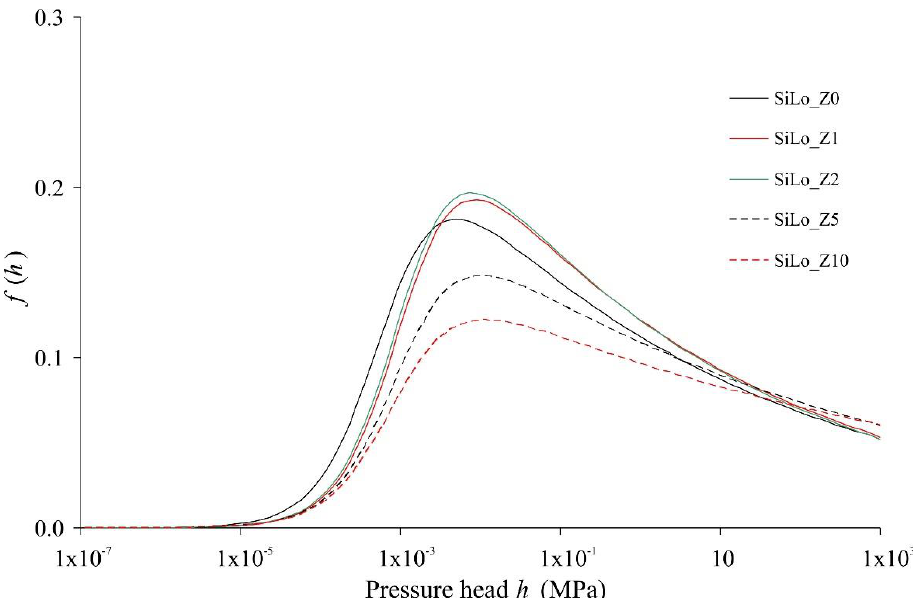
Figure 6. Pore size distribution (PSD) as a function of the pressure head h with reference to the selected soil–zeolite mixtures: SiLo_Z0: soil without zeolite; SiLo_Z1: soil with 1% of zeolite; SiLo_Z2: soil with 2% of zeolite; SiLo_Z5: soil with 5% of zeolite; SiLo_Z10: soil with 10% of